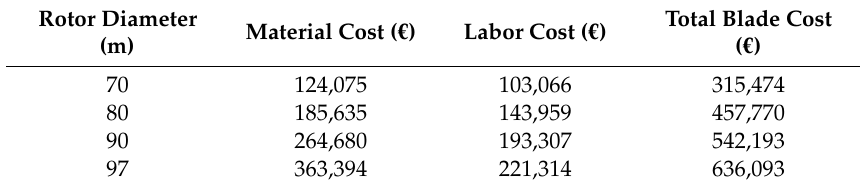
Table 4. Costs of material and labor and total blade cost with rotor diameter. Source: Fingersh et al. [21]. Rotor